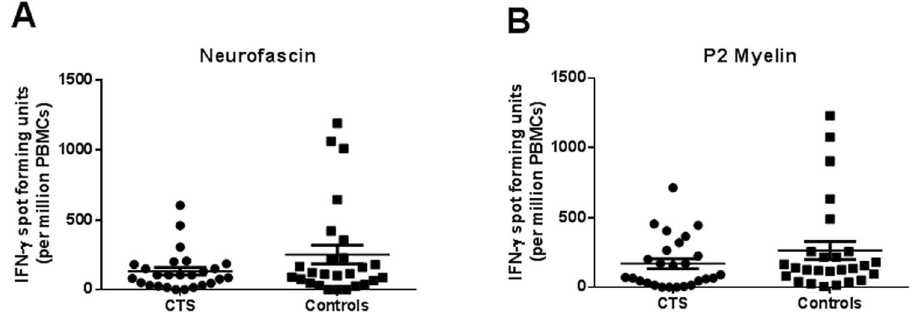
Figure 4. Absence of difference in the level of neurofascin/P2-specific T cells between CTS patients and healthy controls. ELISPOT assay was used for detection of interferon (IFN)- γ -secreting cells following stimulation with peripheral myelin antigens in PBMCs from CTS patients (n = 26) and normal controls (n = 26). There was no difference between groups in the total number of IFN- γ spots per million cells in response to neurofascin ( A ) and P2 myelin ( B ). Data are expressed as mean +